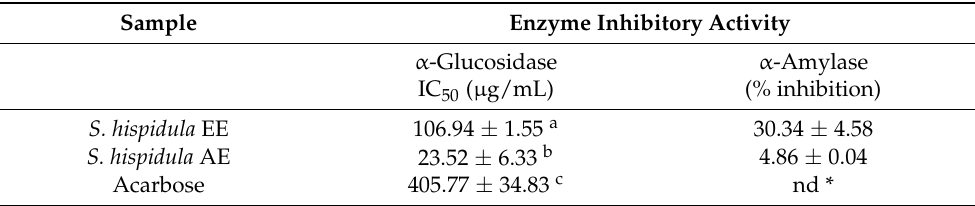
Table 4. Enzyme inhibitory activities of S. hispidula extracts against the activity of α -glucosidase and α -amylase enzymes. Sample Enzyme Inhibitory Activity α -Glucosidase α -Amylase IC 50 ( µ g/mL) (% inhibition) S. hispidula EE 106.94 ± 1.55 a 30.34 ± 4.58 S. hispidula AE 23.52 ± 6.33 b 4.86 ± 0.04 Acarbose 405.77 ± 34.83 c nd